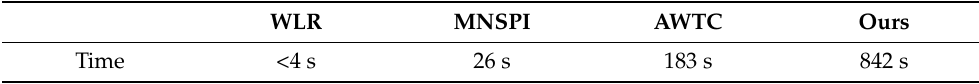
Table 5. Time cost of three comparison methods and our